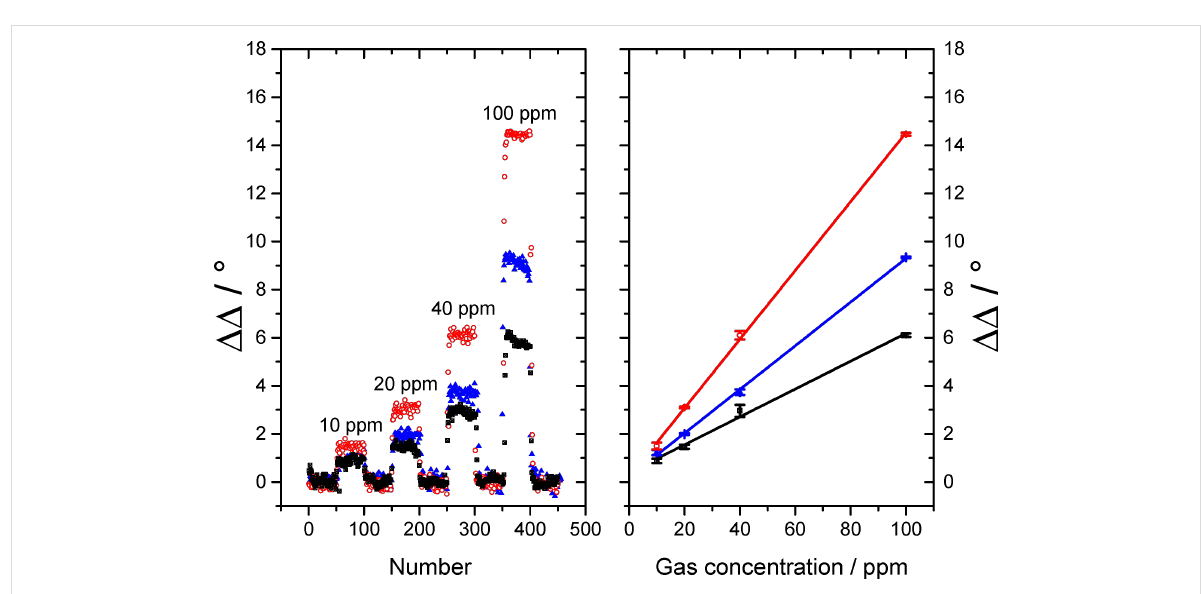
Figure 7: Gas measurement of C 3 H 8 (black rectangle), CO (blue triangle) and H 2 (red dots) with SPREE at an AOI of 44.5° with an Fe:SnO x layer (left). Linearity analysis of the ΔΔ response to the gas concentration (right).